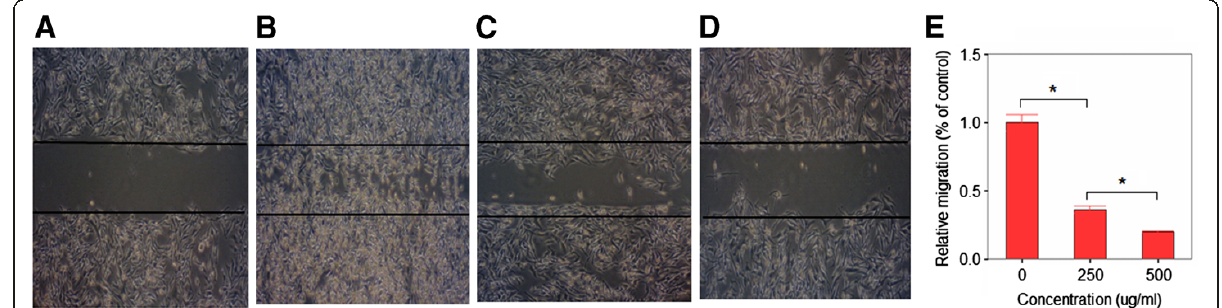
Figure 5 Effect of P. indica root crude aqueous extract on migration of HeLa cells as determined by in vitro “ scratch ” wounjd closure assay. “ Scratch ” wound closure assay of ( A ) HeLa cells after 0 hours. ( B ) HeLa cells after 48 hours incubation with 0 μ g/ml P. indica root aqueous extract. ( C ) HeLa cells after 48 hours incubation with 250 μ g/ml P. indica root aqueous extract. ( D ) HeLa cells after 48 hours